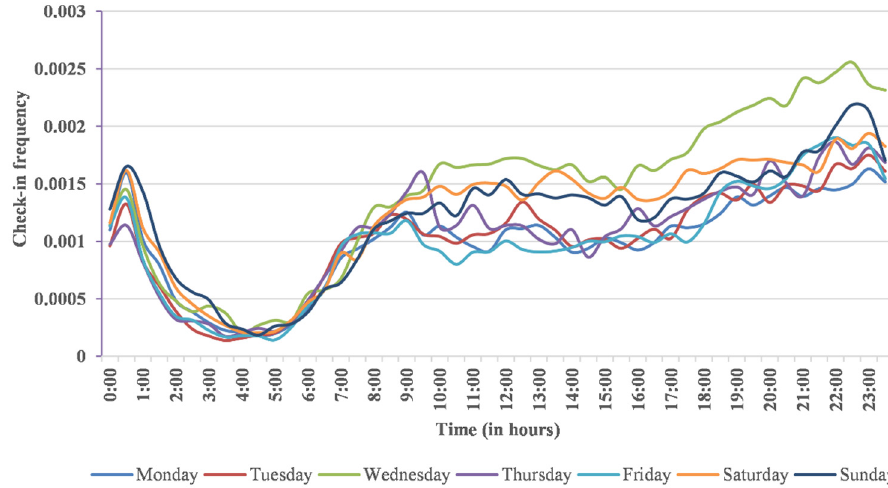
Figure 13. Check-in frequency of males during the course of a week. Figure 13. Check ‐ in frequency of males during the course of a week. Figure 13. Check ‐ in frequency of males during the course of a week.